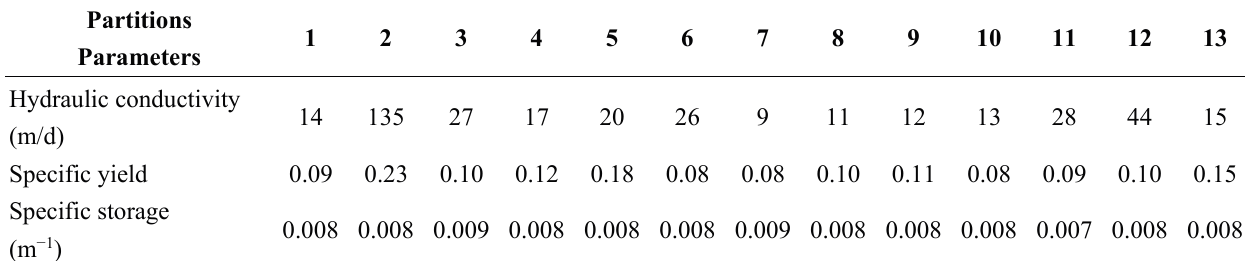
Table 1. Parameters values of study subareas.